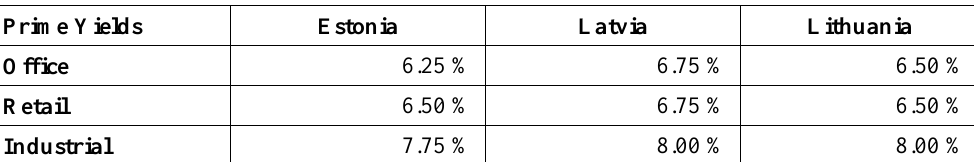
Table 3. Prime yields in the Baltic States by country in 1 st half year 2017 (Colliers International,